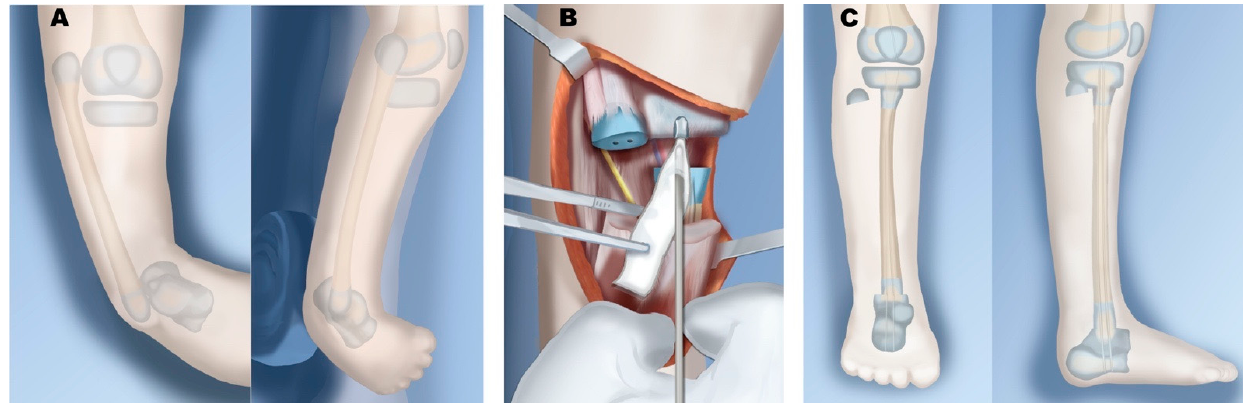
Figure 9. Treatment of Paley type 4B. ( A ) Unossified proximal tibial anlage with no physis. Initial treatment the same as 4A, with fibula distraction and foot correction. ( B ) Insertion of BMP into proximal tibia anlage. ( C ) Fixator removal following healing from physeal sparing proximal fibula osteotomy and transfer to proximal tibia. Physeal-sparing fusion of distal fibula to talus.